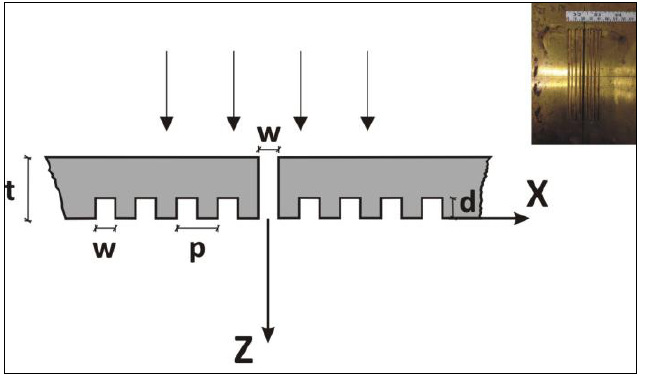
Figure 1. Schematic diagram of the corrugated plate. The inset shows a picture of the